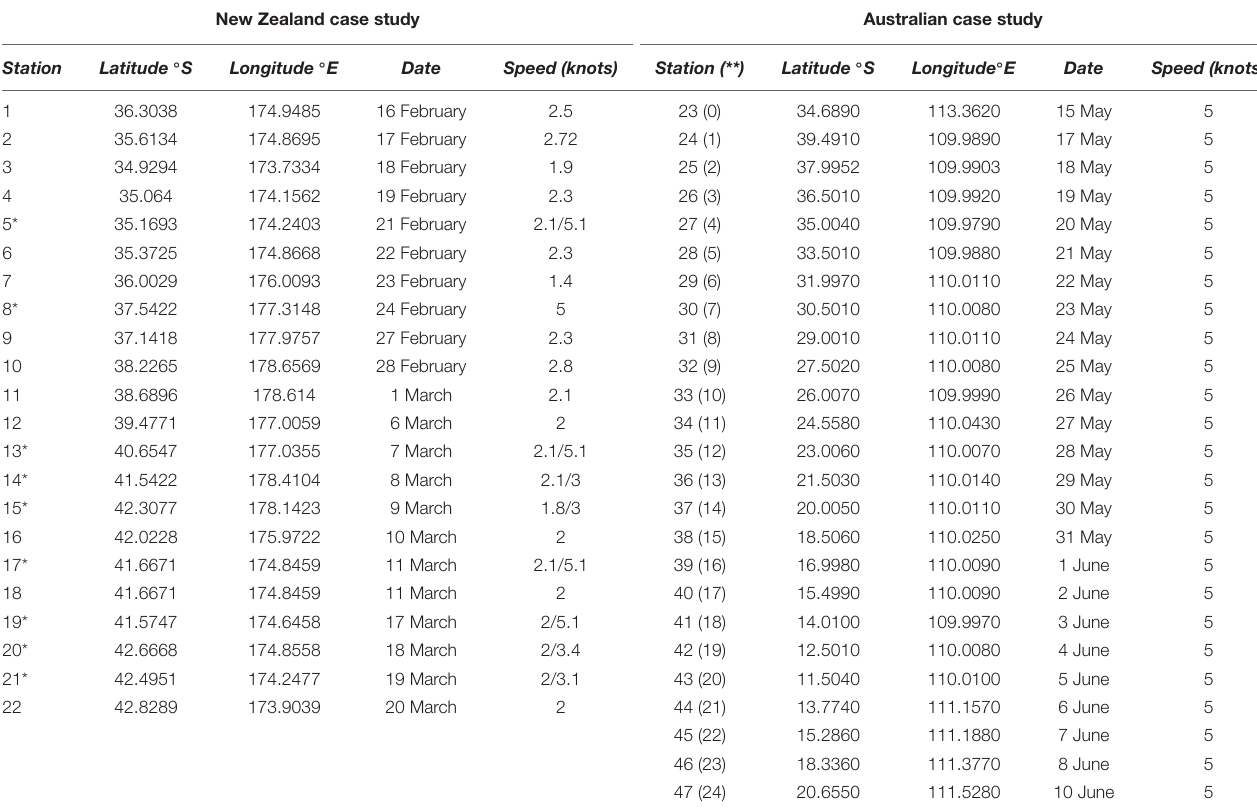
TABLE 1 | Sampling stations for the New Zealand and Australian case studies and corresponding latitude, longitude, date (day and month in 2019), and sampling speed. New Zealand case